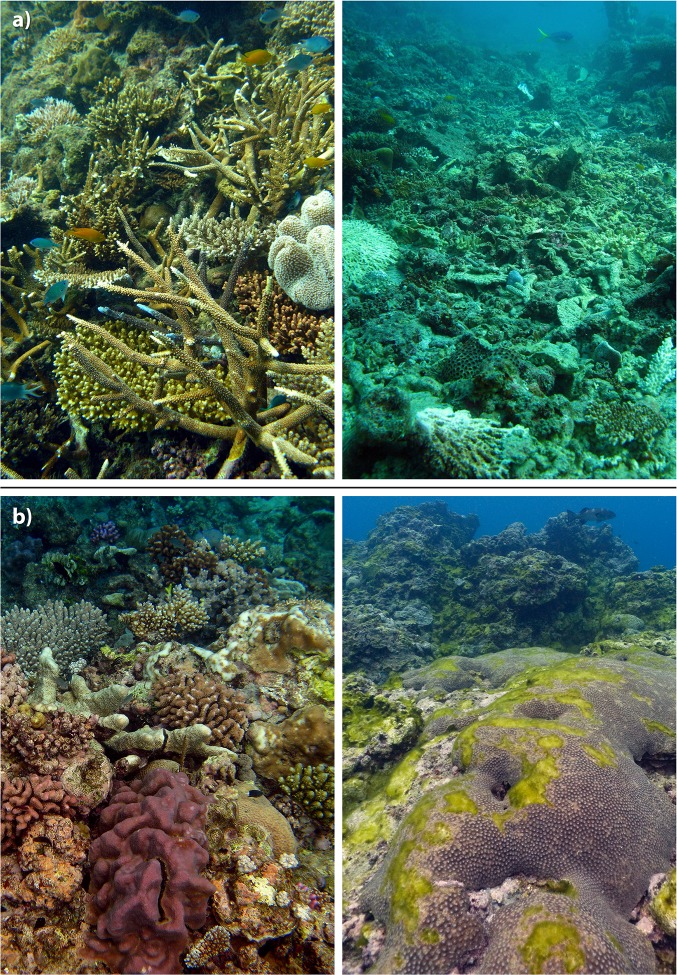
Photos taken within 50 m showing the patchiness of damage at Bramble Reef in the very destructive wind zone and Dip Reef in the destructive wind zone.See Fig. 1 for destructive and very destructive wind zone boundaries and Fig. 2 for reef locations.